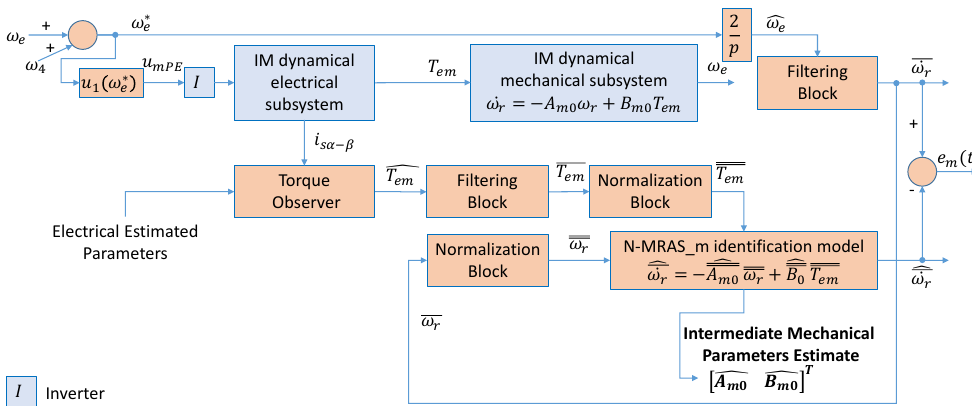
Figure 7. Block diagram of the proposed N-MRAS_m.